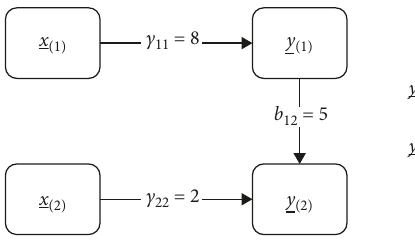
Figure 4: The path model for Example 1. Table 1: 3SLS and FIML D -optimal design for Example